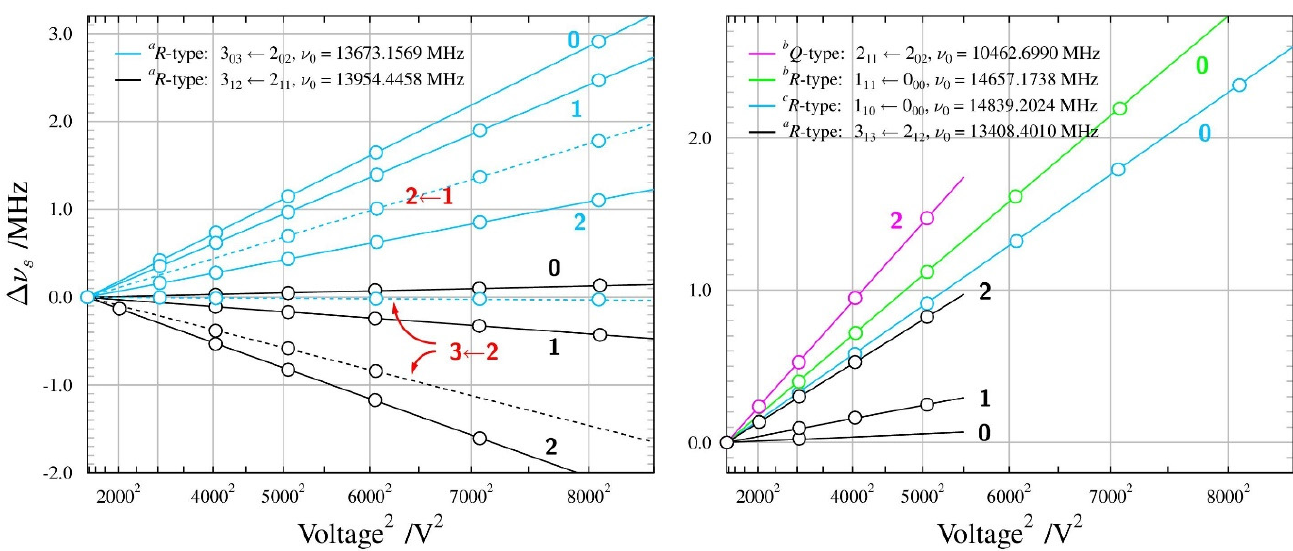
Figure 5. Summary of Stark measurements for the most stable, TGt , conformer of n -butanol (see the caption to Figure 3 for details). There are three non-zero electric dipole moment components in this molecule and it was possible to measure Stark lobes for rotational transitions allowed by all three components. In addition, the small non-degeneracy between the two nominally degenerate modes of the cylindrical Fabry-Perot resonator (see Ref. [24]) allowed for measurement also of several ∆ M = +1 Stark lobes, with M values marked in red.